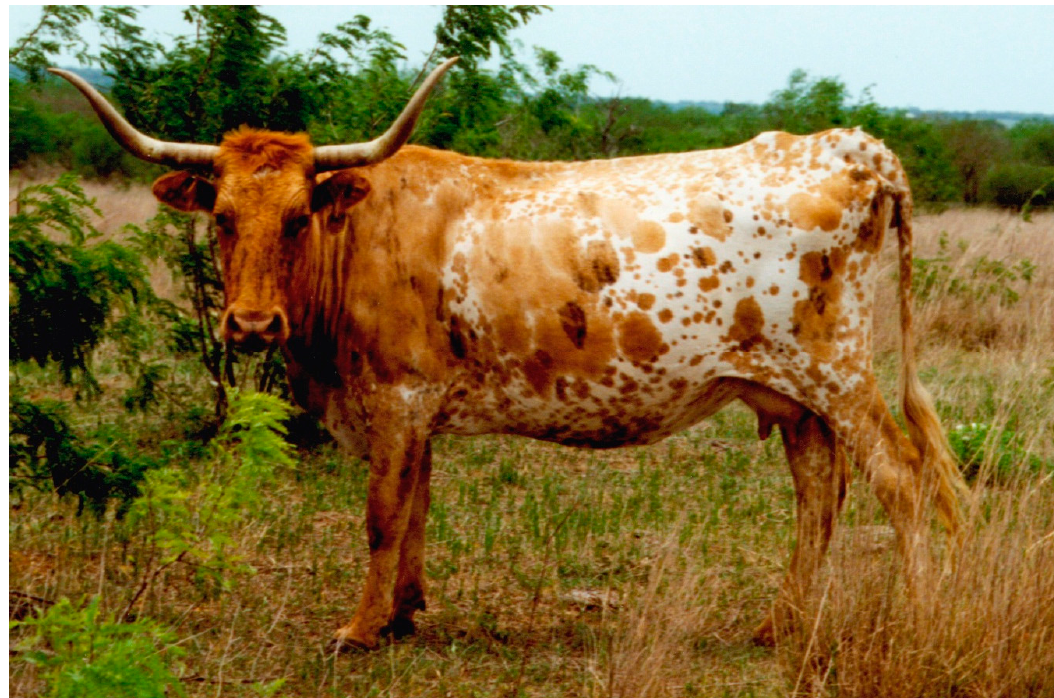
Figure 2. Texas Longhorn cow of traditional criollo type. Photo by D.P. Sponenberg.